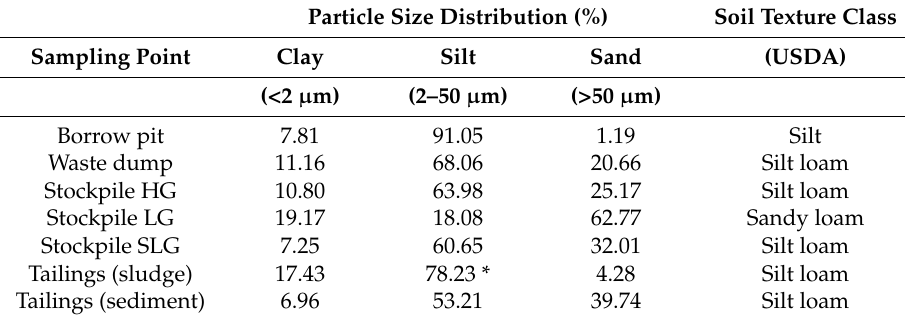
Table 2. Particle size distribution of the soil, sludge and sediment at Selinsing Gold Mine waste.